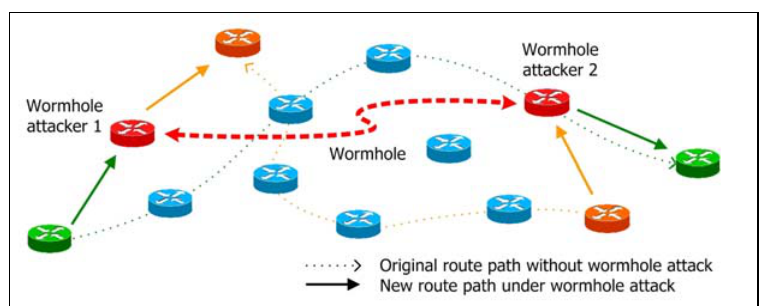
Figure 1. The wormhole attack in